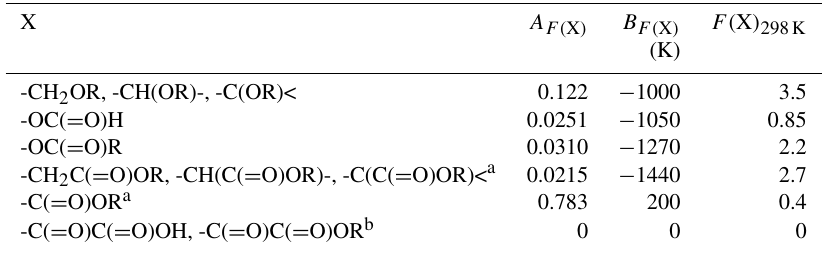
Table 8. Substituent factors, F( X ) , for oxygenated groups in ethers, esters and carboxylic acids, and their temperature dependences